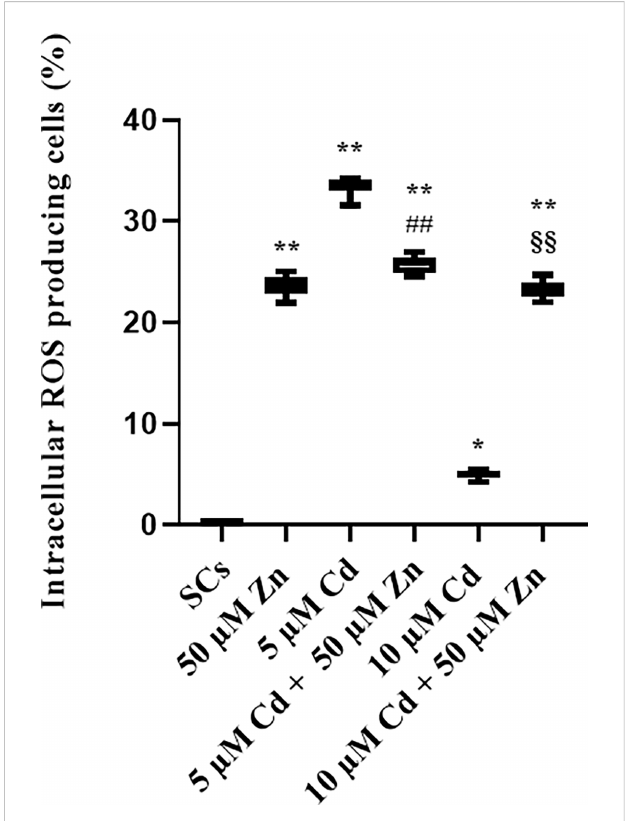
FIGURE 9 ROS assay. Intracellular ROS-producing cells in the absence (unexposed-control group, SCs) or presence of 5 or 10 µM CdCl 2 and/ or 50 µM ZnCl 2 for 48 h. Data presented as the mean ± SEM. (* p < 0.05 and ** p < 0.001, ## p < 0.001 vs . 5 µM Cd, §§ p < 0.001 vs . 10 µM of three independent experiments, each performed in